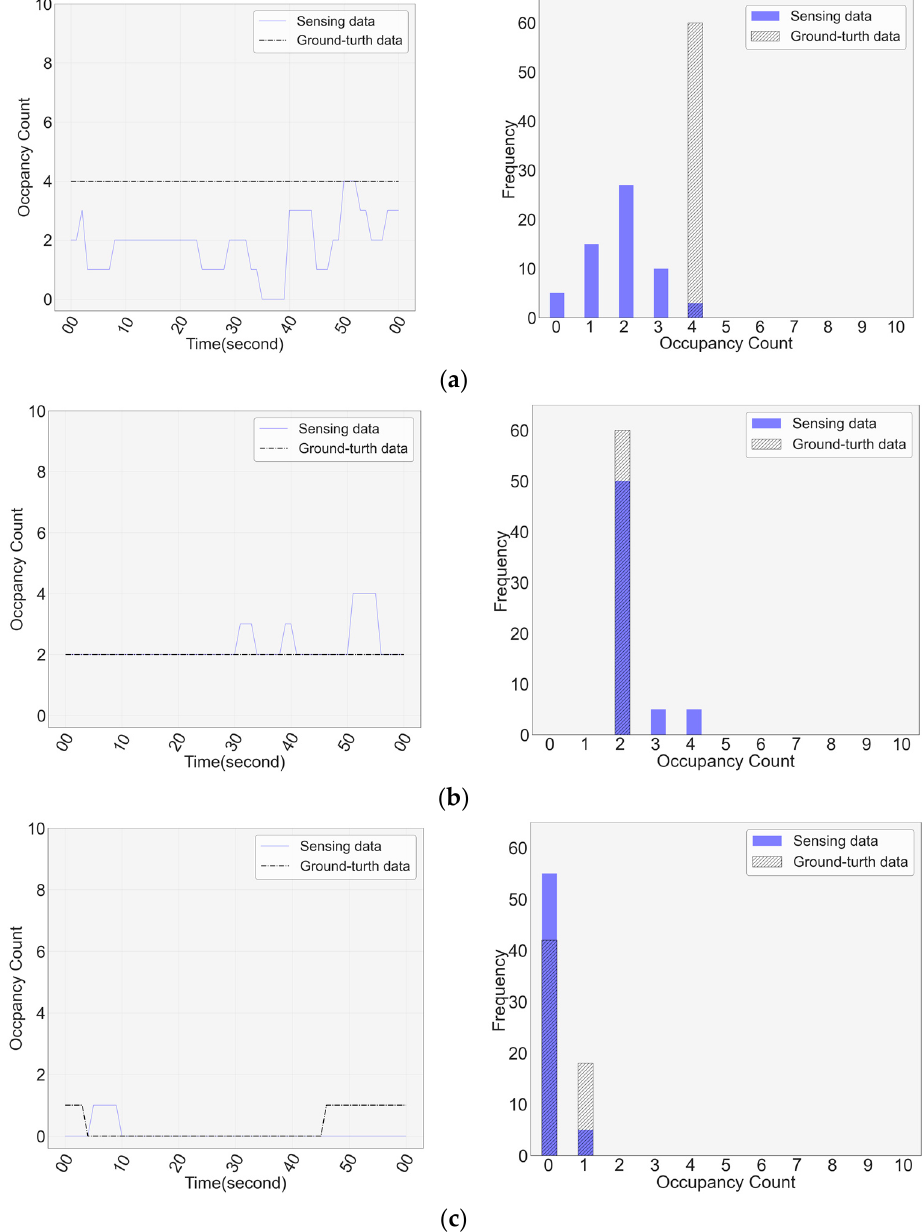
Figure 10. Pattern and histogram of sensing and ground-truth data: ( a ) case where the sensing data fluctuate significantly; ( b ) case where sensing data are partially incorrectly sensed; ( c ) case where ground-truth data have fluctuations.